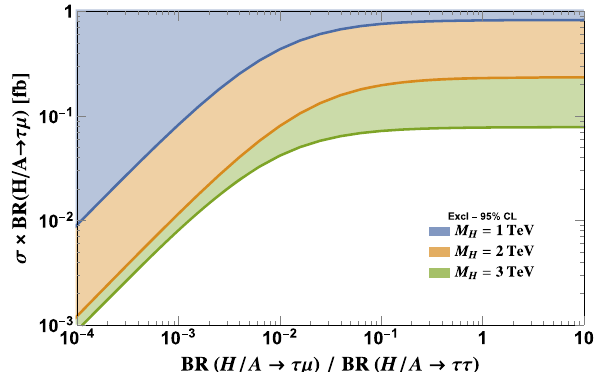
Fig. 6 95% exclusion limits on the cross section of the LFV process pp → H / A → τμ when the LFC decay H / A → ττ is available. The three contours are obtained for L = 300 fb − 1 and correspond to M H = 1 TeV (blue), 2 TeV (orange) and 3 TeV